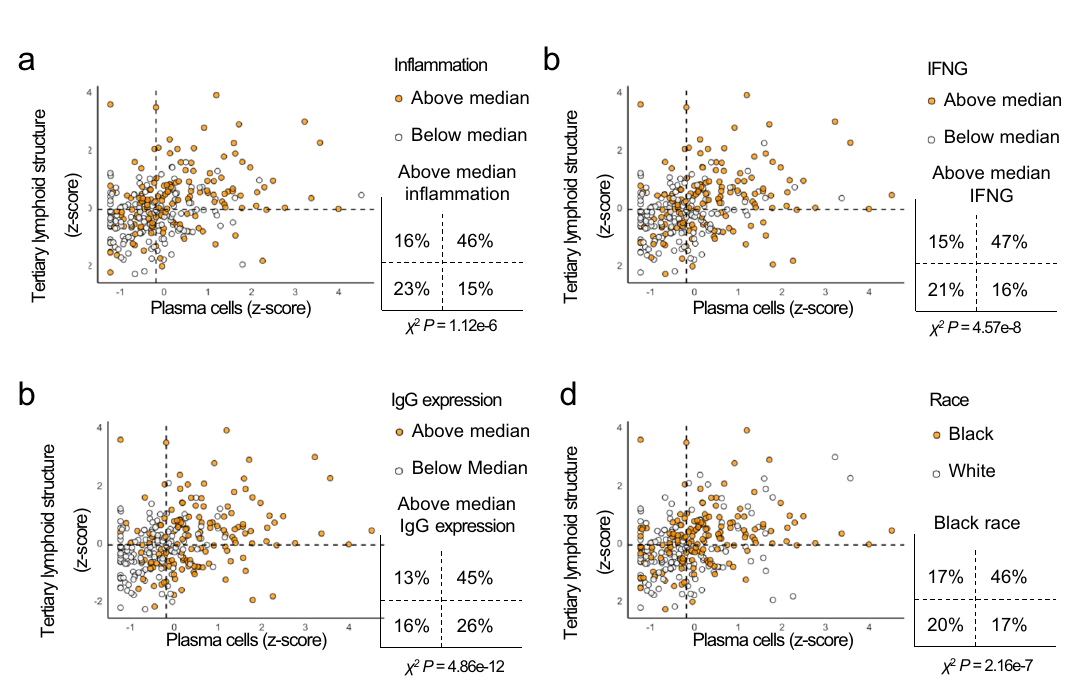
Fig. 2 Intratumoral plasma cell and tertiary lymphoid structure content de fi ne a distinct subset of prostate cancer. Antigen presentation, cytokine- mediated signaling, and release of tumor-speci fi c antibodies are increased when B-cells localize to tertiary lymphoid structures 17 . We show tumors with high tertiary lymphoid structure activity and plasma cells are enriched with high in fl ammation, IFNG, IgG expression, and self-identi fi ed Black race ( a – d ). Dashed horizontal and vertical lines indicate the median for tertiary lymphoid structure activity and plasma cells, respectively. χ 2 P -values are all two-sided. Abbreviation: IFNG interferon